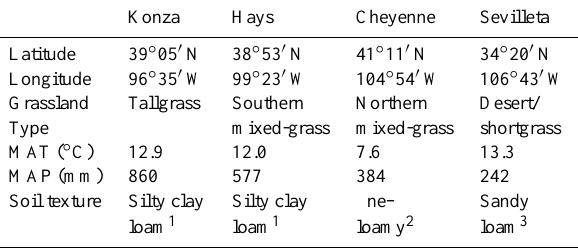
Table 1. Key climate, plant, and soil characteristics of four grass- land ecosystem types located within the Great Plains, USA.